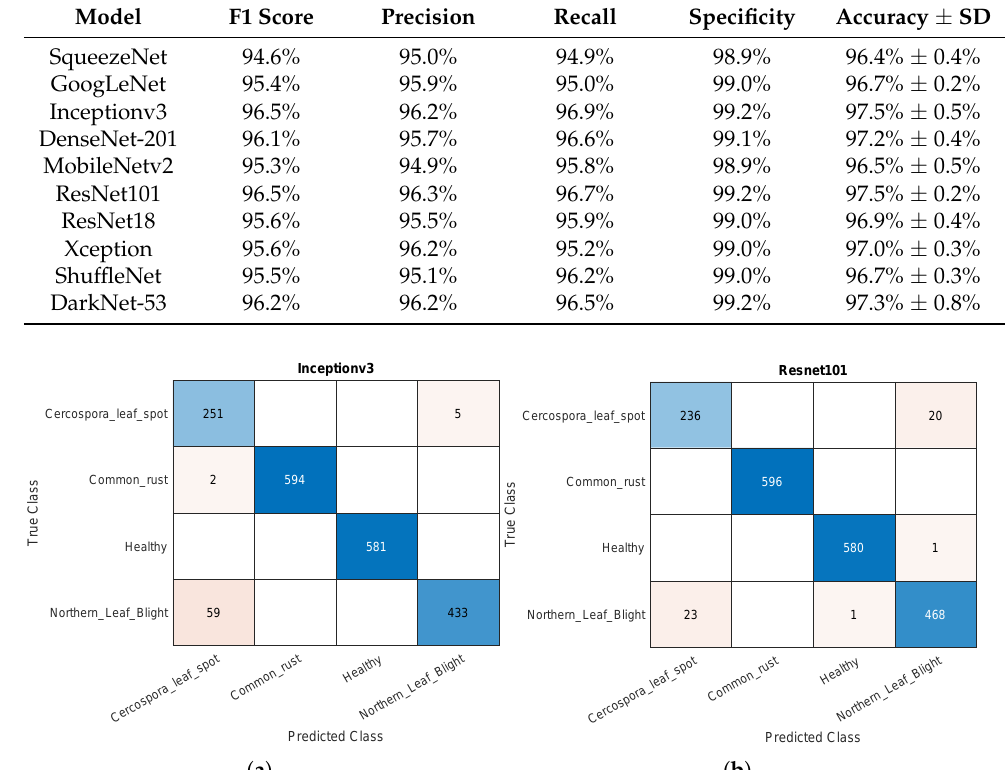
Table 2. The mean overall F1 score, precision, recall, specificity, and accuracy using 50% of the data for training. The results are an average of 10 runs.